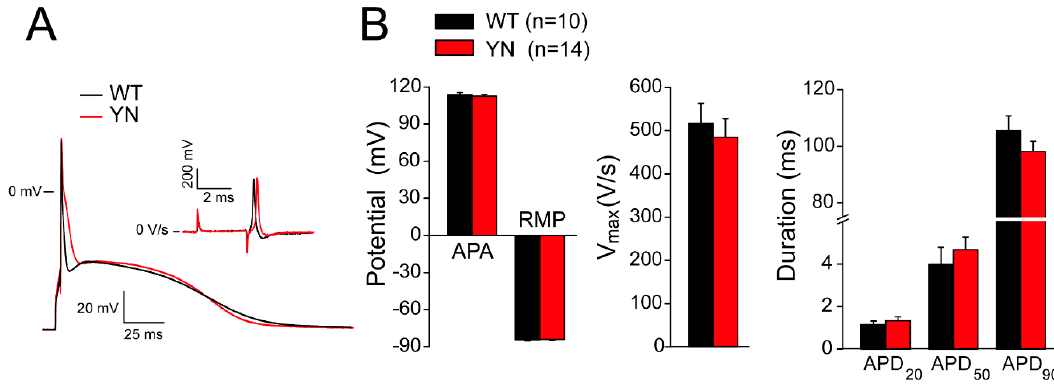
Figure 5. Action potential properties in isolated wild-type and Scn5a -p.Y1981N mouse cardiomyocytes. ( A ) Typical examples of action potentials (APs) triggered at 2 Hz and first derivative (dV / dt) of the AP upstroke (inset) in wild-type (WT) and Scn5a -p.Y1981N (YN) mouse cardiomyocytes. ( B ) Average values for AP amplitude (APA), resting membrane potential (RMP), maximal upstroke velocity (V max ; measured as the maximal dV/dt of the AP upstroke) and AP duration at 20%, 50%, and 90% repolarization (APD 20 , APD 50 , APD 90 ) at the stimulation frequency of 2 Hz in WT ( n = 10 cardiomyocytes from six mice) and YN cardiomyocytes ( n = 14 from five mice).